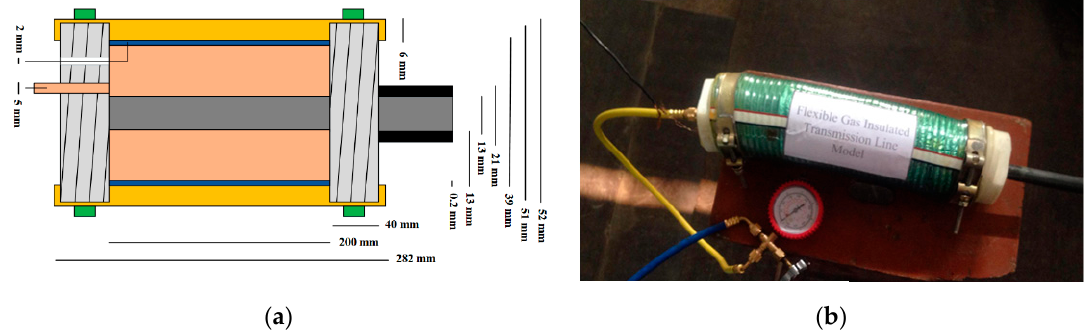
Figure 17. ( a ) Dimensional specifications of the scaled FGIL model and ( b ) the fully developed scaled FGIL model.